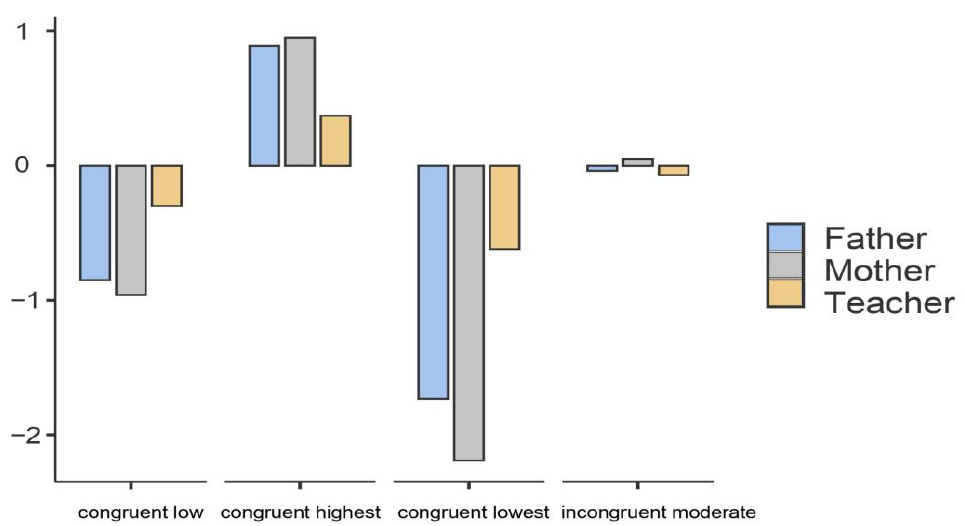
Figure 2. Four warmth profiles based on standardized scores of father warmth, mother warmth, and teacher warmth. Note . N = 738.